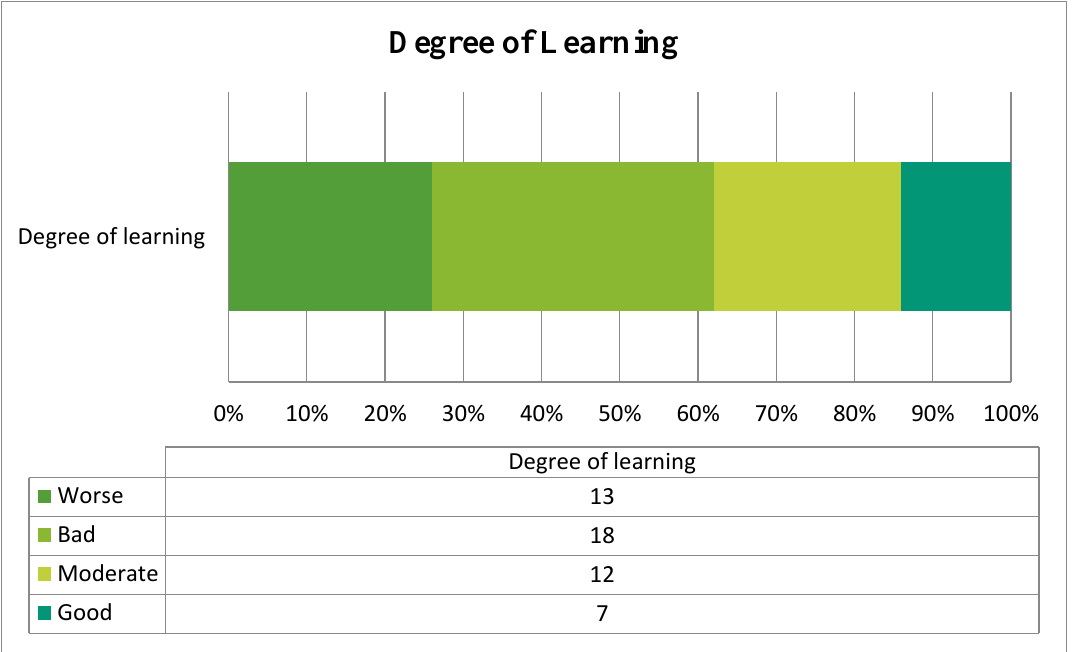
Figure 2 : Figure 2 shows the degree of learning of the final year students using staple scale. the graph shows that among the respondents 13 students think that the degree of learning is worse, while 18 students think it is bad, on the contrary 12 students think that the degree of learning is moderate and 07 students thinks it is good. The